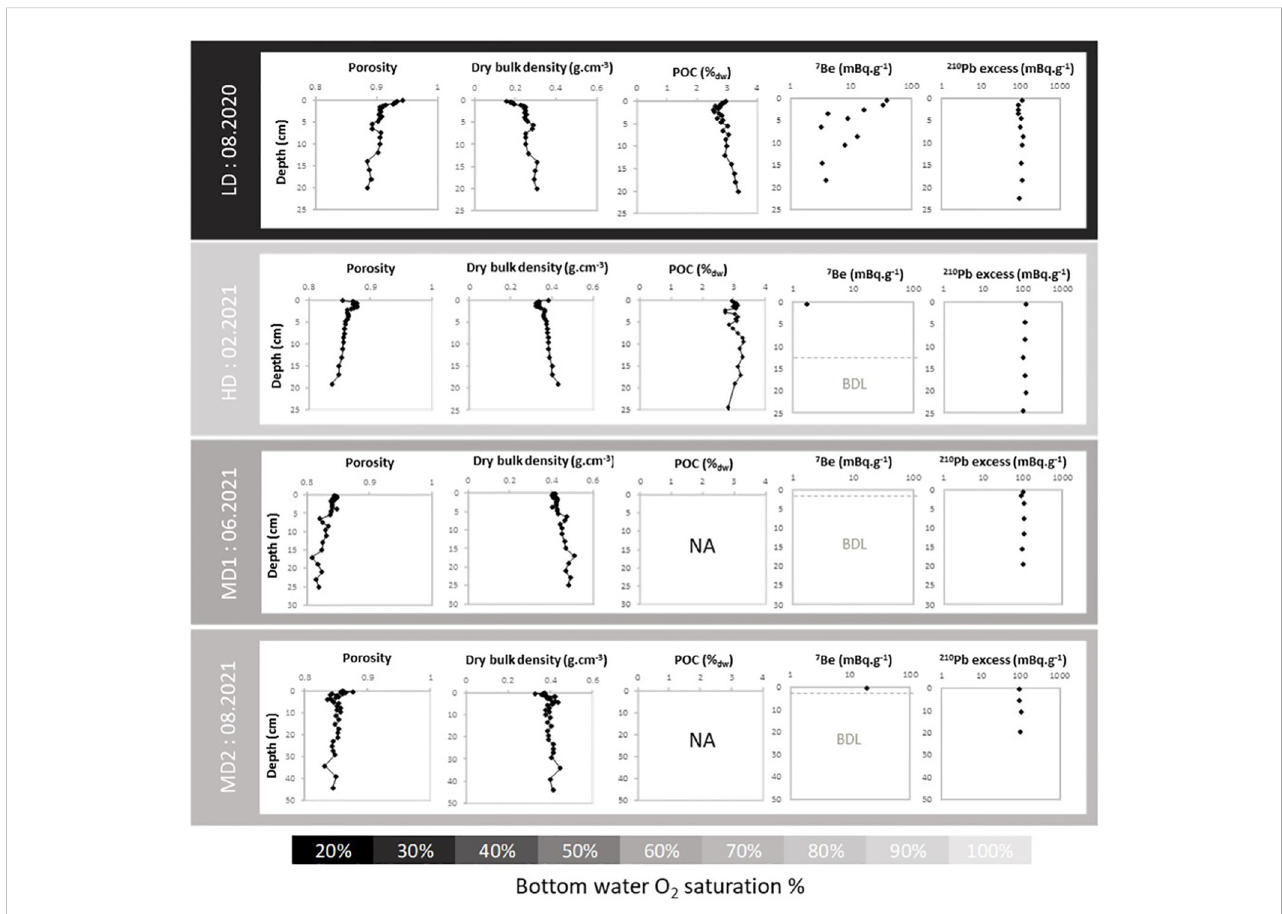
FIGURE 3 Pro fi les of porosity, dry bulk density (g*cm − 3 ), particulate organic carbon (%), and 7 Be and 210 Pb xs activities (mBq g − 1 ) with depth in sediment at Le Pellerin. BDL, below detection limit; NA, not